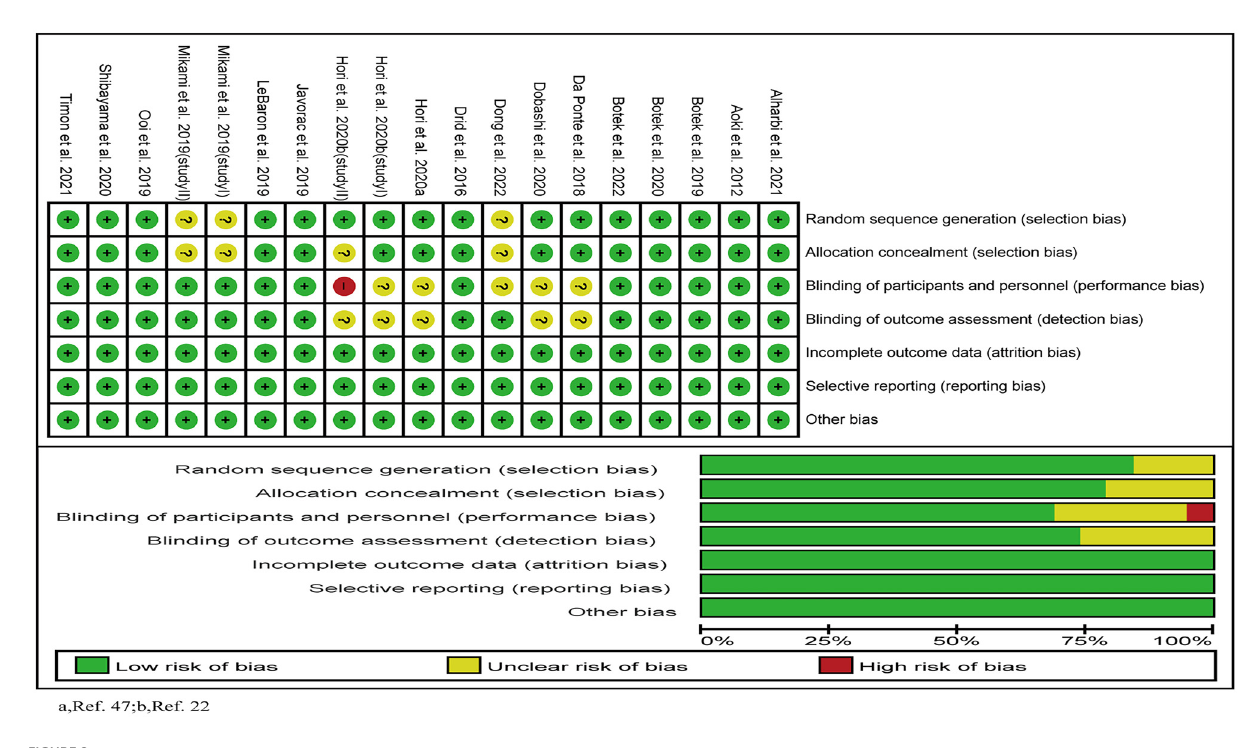
FIGURE2 Risk of bias in the included studies.